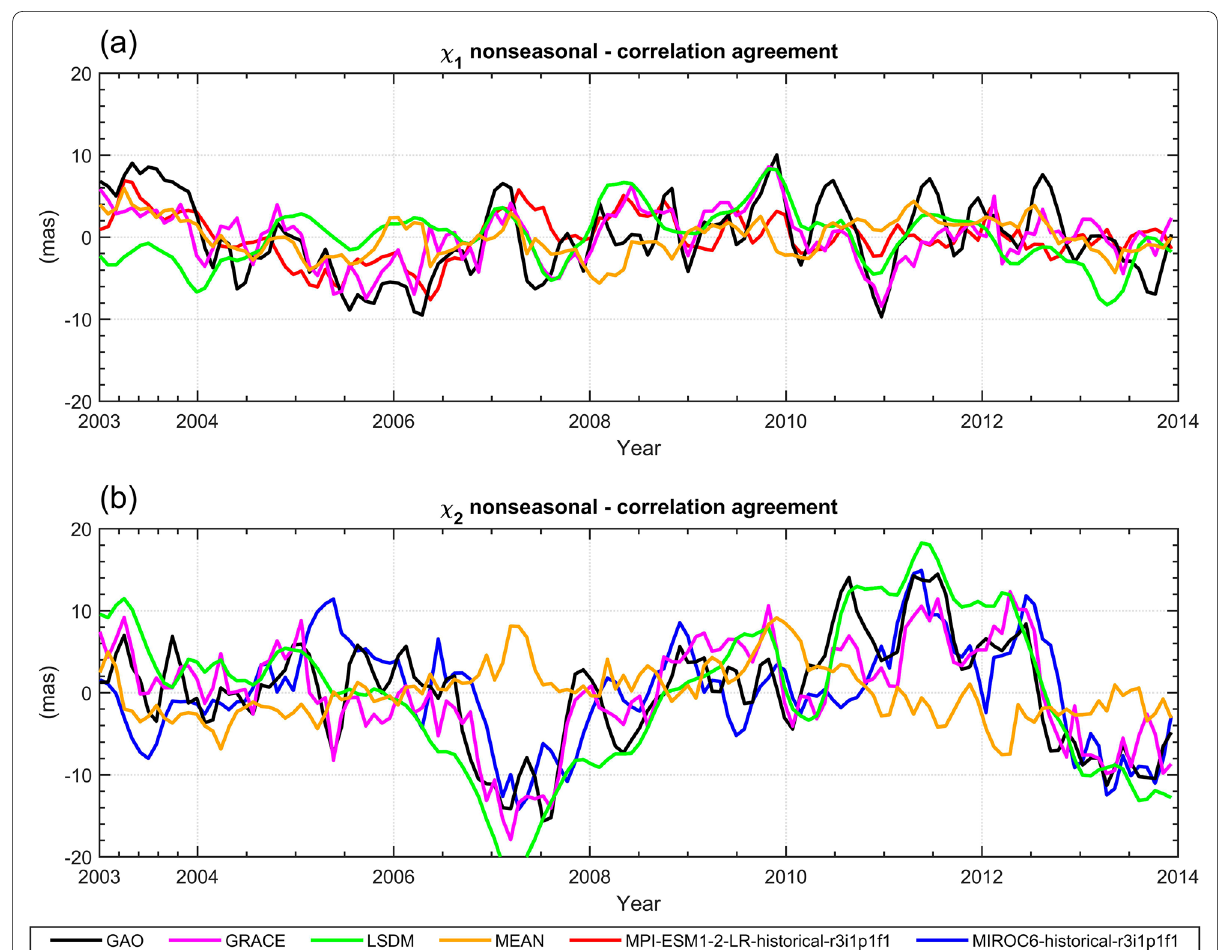
Fig. 13 The models best suited to GAO in terms of the highest correlation coefficients (red line for χ 1 in Fig. 13a and blue line for χ 2 in Fig. 13b). The results obtained from GRACE, LSDM and MEAN model are also